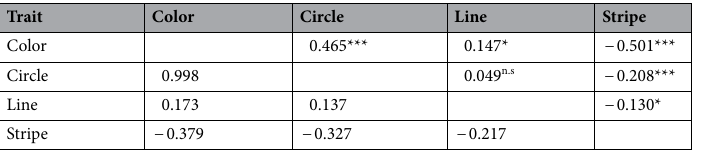
Table 2. Phenotypic and genetic correlations (upper triangle and lower triangle, respectively), between color traits of C. edule included in this study. (*** p < 0.001, * p < 0.05).